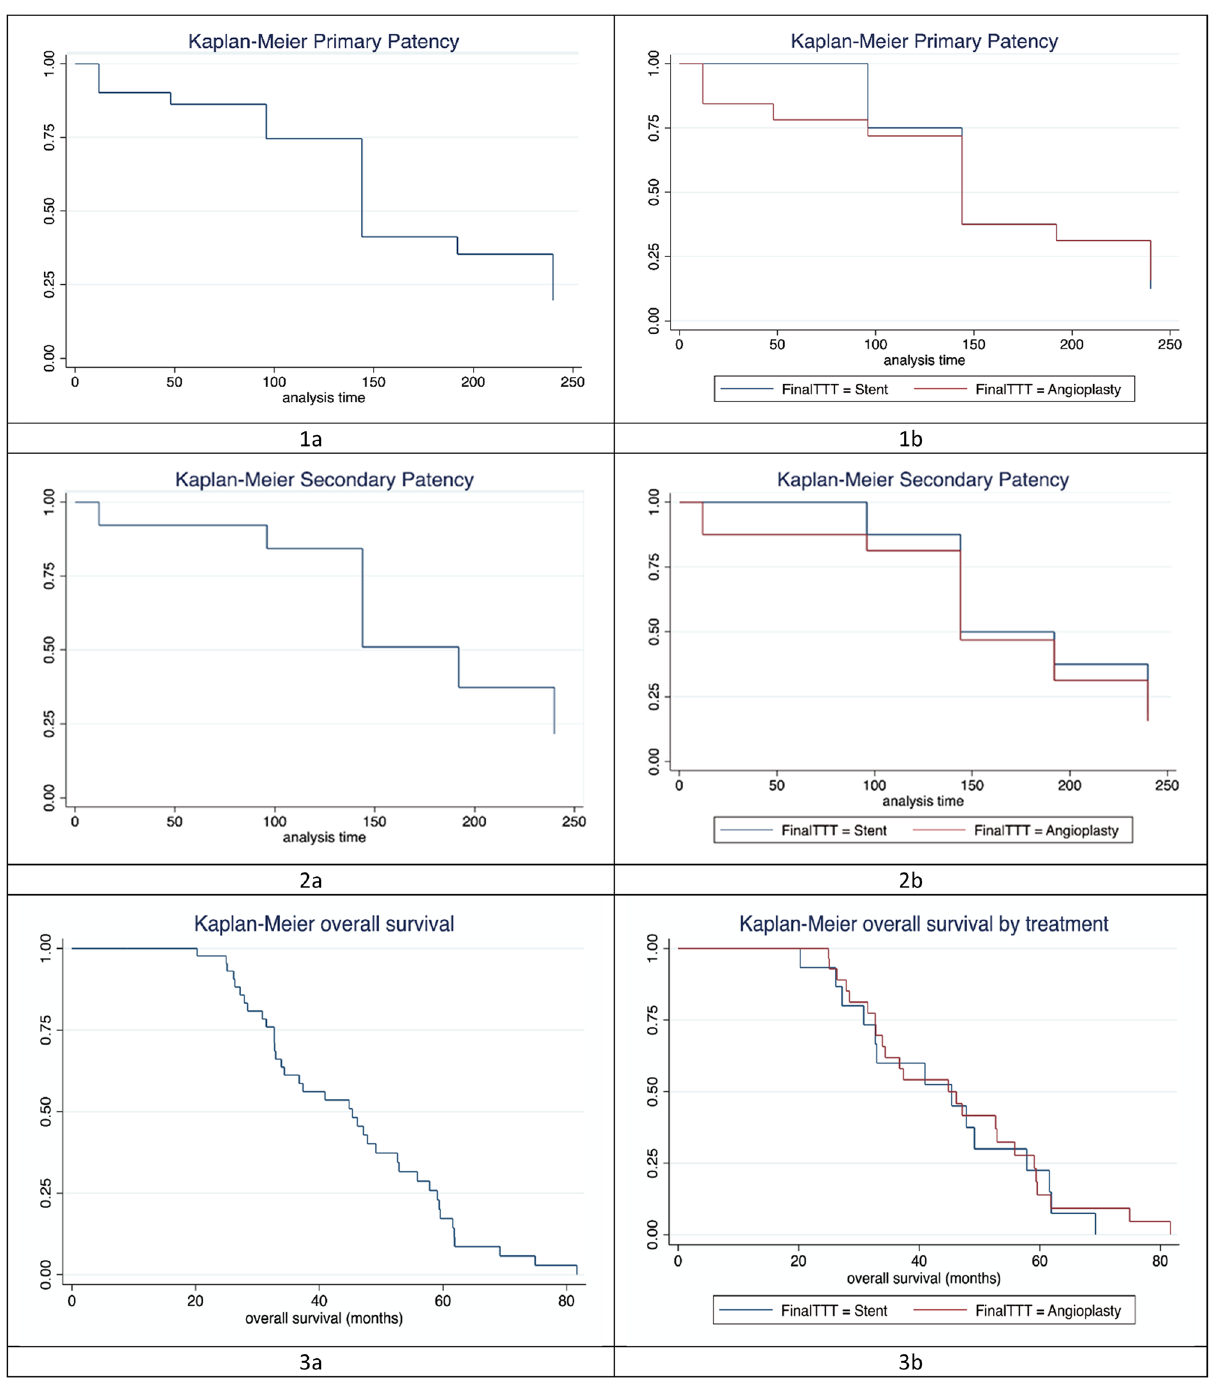
Figure 2. Kaplan–Meier analysis of primary patency ( 1a , b ), secondary patency ( 2a , b ), and survival time ( 3a , 3b ) in the total study population ( 1a , 2a , 3a ) and subgroup analysis according to type of intervention ( 1b , 2b , 3b